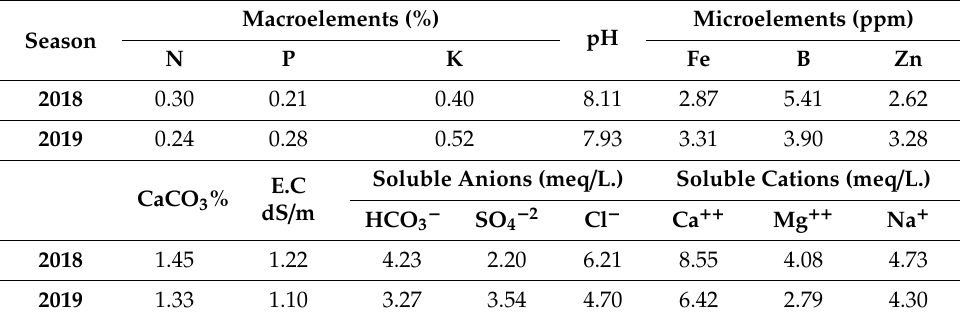
Microelements (ppm) pH